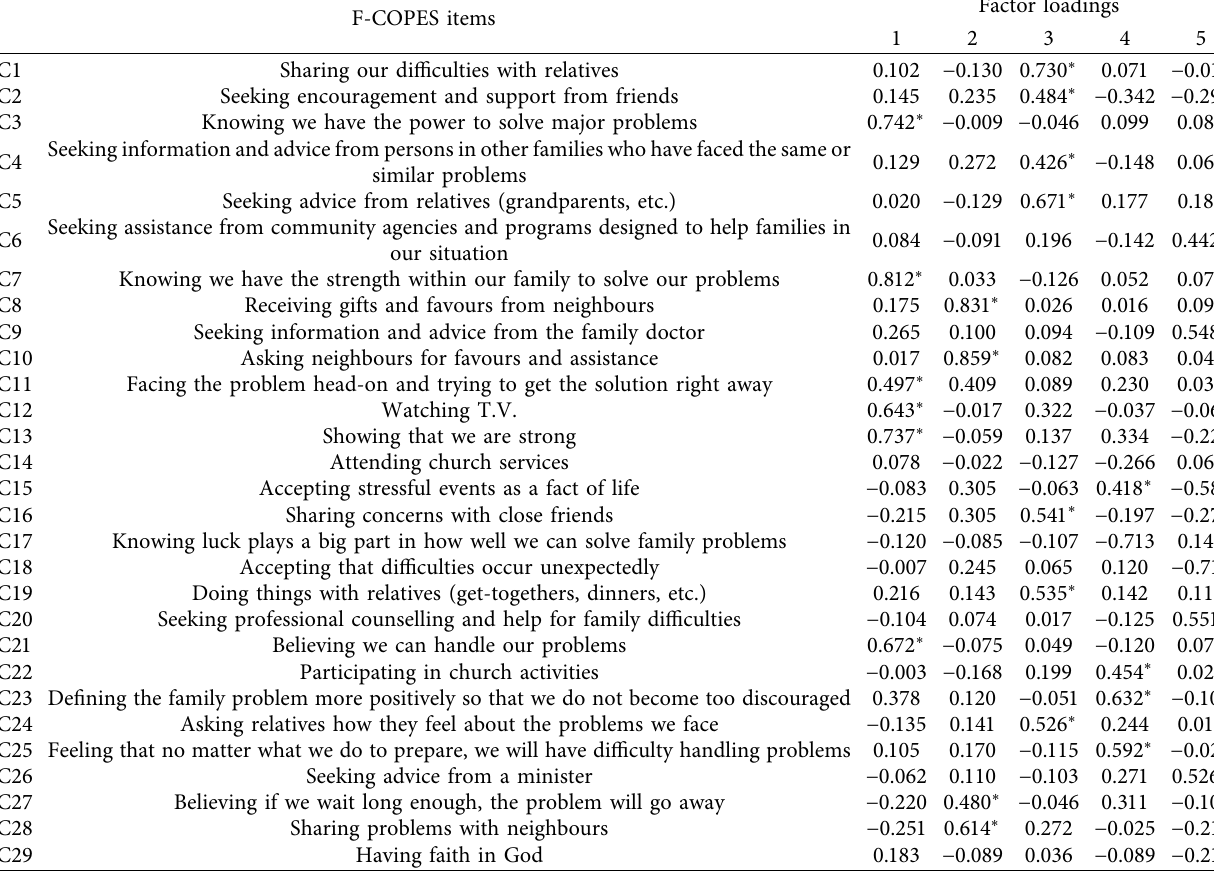
Table 5: Five-factor loading of items in the coping strategy (F-COPES) assessment scale ( n � 113).